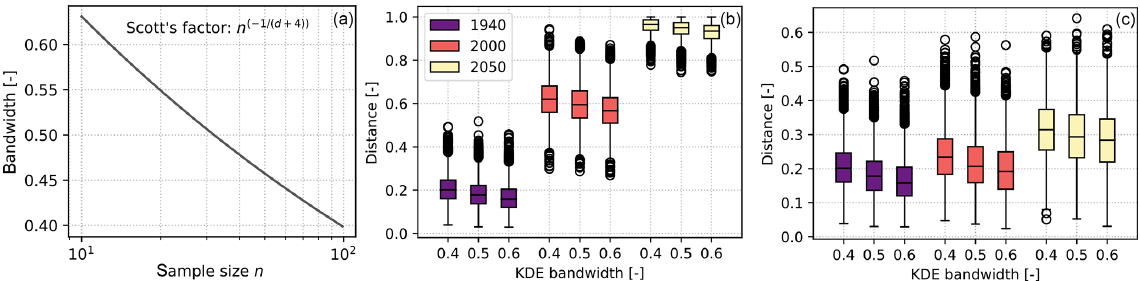
Figure 4. HD sensitivity to KDE bandwidth. (a) Automatic bandwidth selection in Python’s “scipy.stats” KDE (Virtanen et al., 2020) is based on Scott’s factor (Scott, 2015), where n is the sample size and d is the dimension. For 1-dimensional data, sample sizes between 10 and 100 correspond to bandwidths of 0.65 to 0.4. (b) Sensitivity in the HD for example type 1 (Fig. 3a, c, and e). (c) Sensitivity in the HD for example type 2 (Fig. 3b, d and f) at years 1940, 2000, and